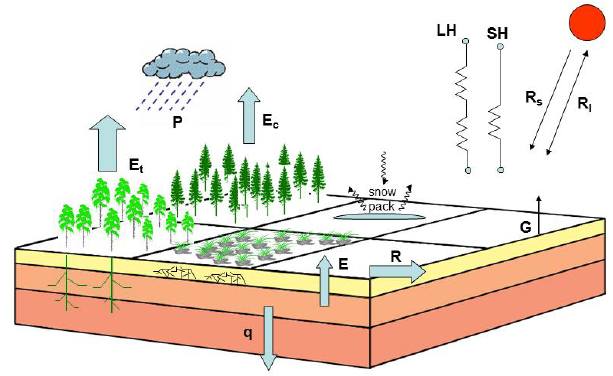
Figure 1. Schematic of “generation 2A” LSMs. The energy bud- get is represented by short-wave radiation ( R s ), long-wave radiation ( R l ), latent heat flux (LH), sensible heat flux (SH) and ground heat flux ( G ). The water budget is represented by P (precipitation), E (bare ground evaporation), E t (transpiration), E c (evaporation from canopy interception) and surface runoff ( R ). The water budget is coupled with the energy budget, but hydrological processes are rep- resented very simply; for example, subsurface runoff is represented only by vertical drainage ( q ). Precipitation, vegetation type and soil properties are treated as constant within each grid cell.